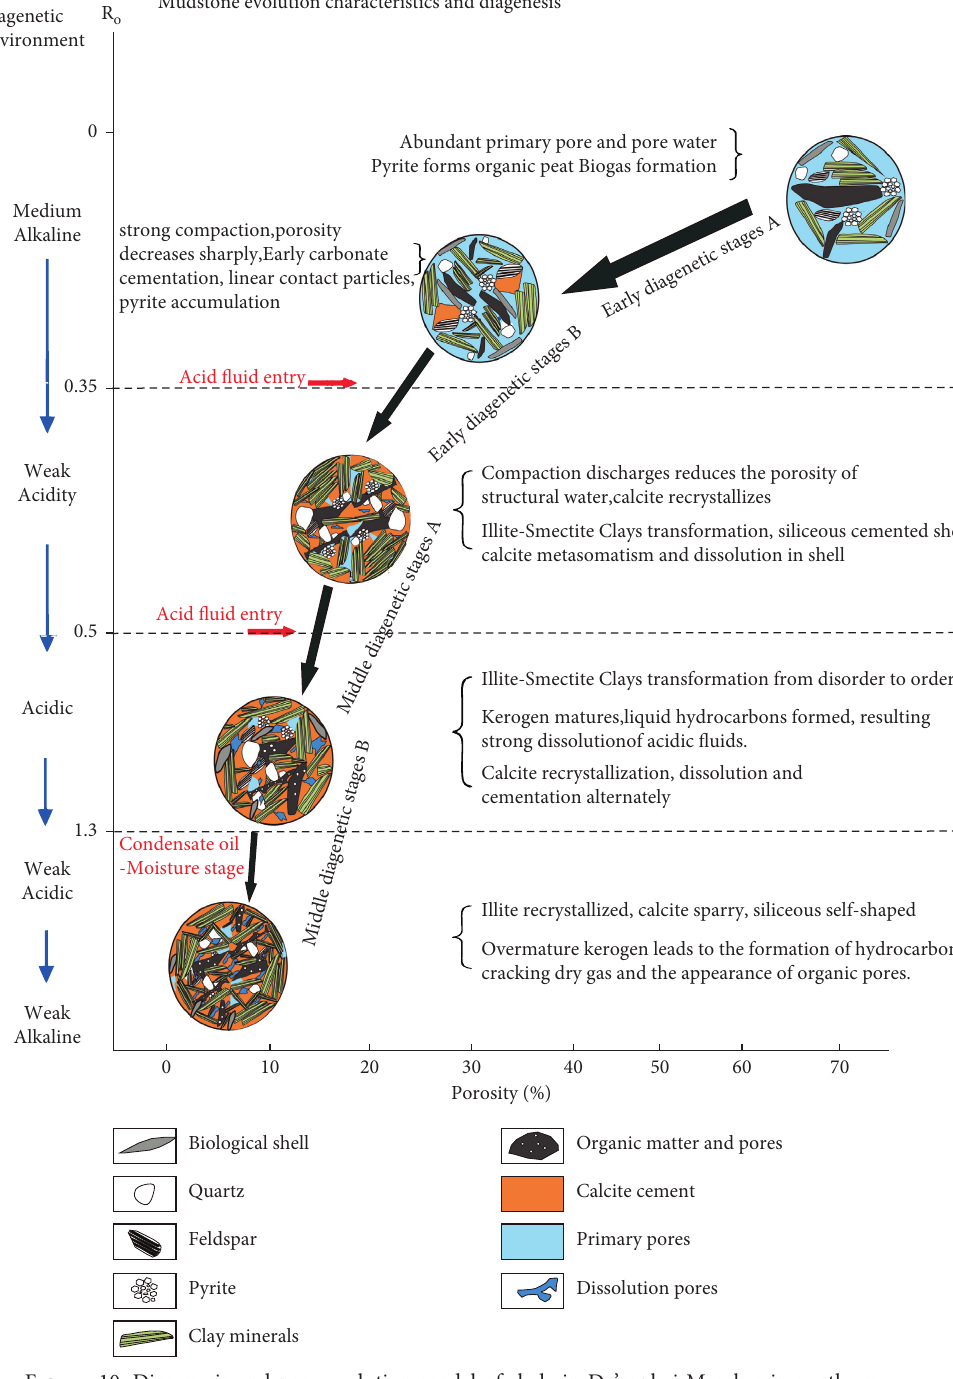
Figure 10: Diagenesis and pore evolution model of shale in Da’anzhai Member in northern